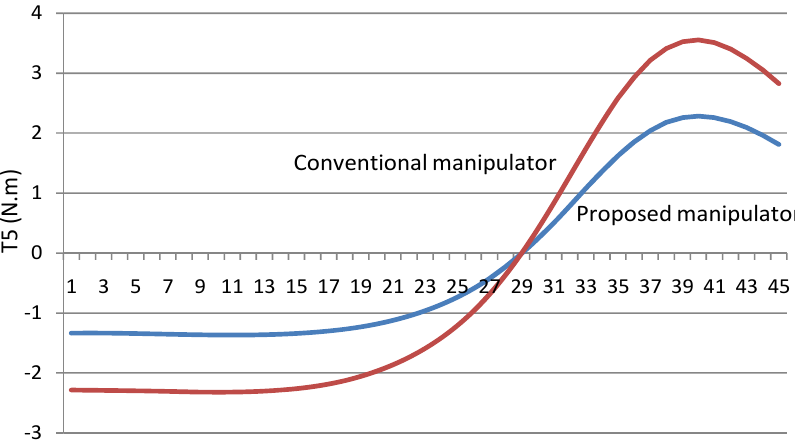
Figure 14. The values of the torques of the fifth joint using the both